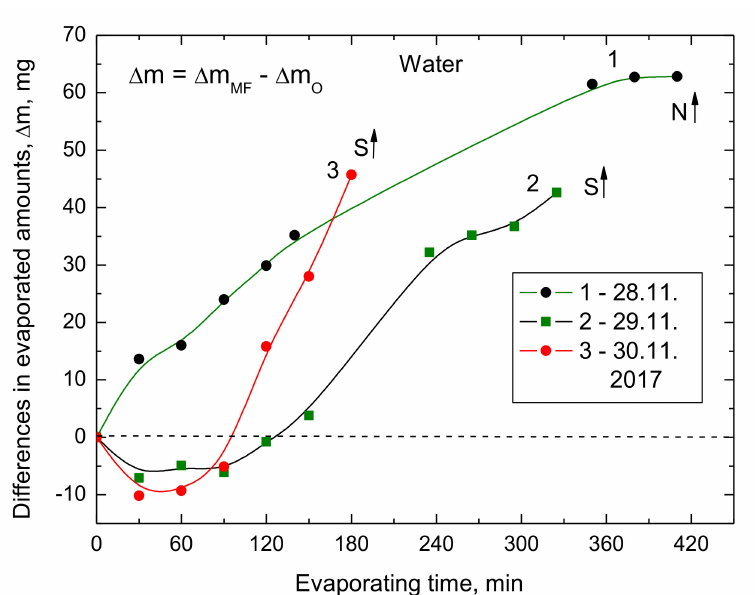
Figure 5. Differences in the evaporated amounts of water depending on which the magnet pole, north N ↑ or south S ↑ , was directed upward.